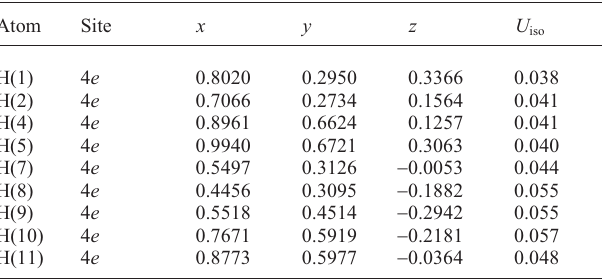
Table 2. Atomic coordinates and displacement parameters (in Å 2 )